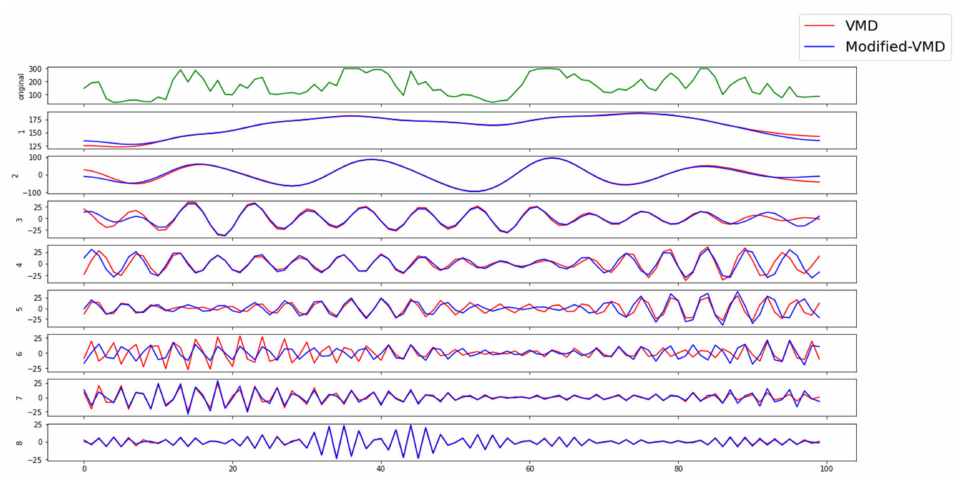
Figure 2. Data decomposition comparison between VMD and